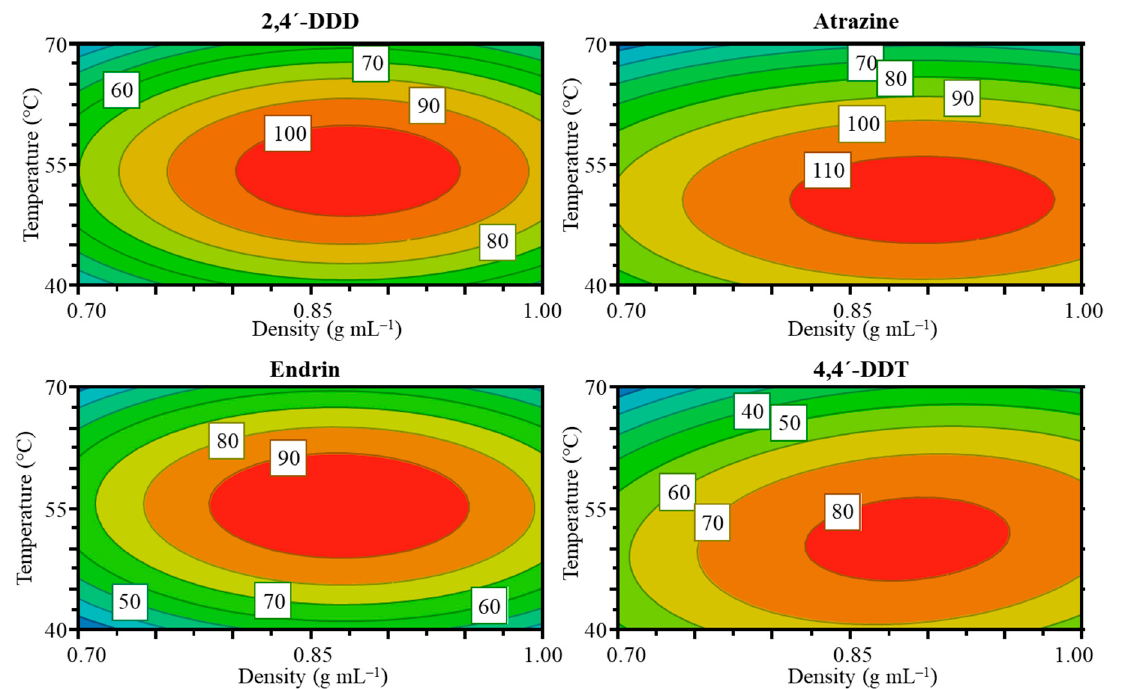
Figure 3. Response surface contour plots for analyte recoveries (%) vs. the extraction variables temperature ( ◦ C) and density (g mL − 1 ). Contour plots for volume / density and temperature / volume are found in the Supporting Information.